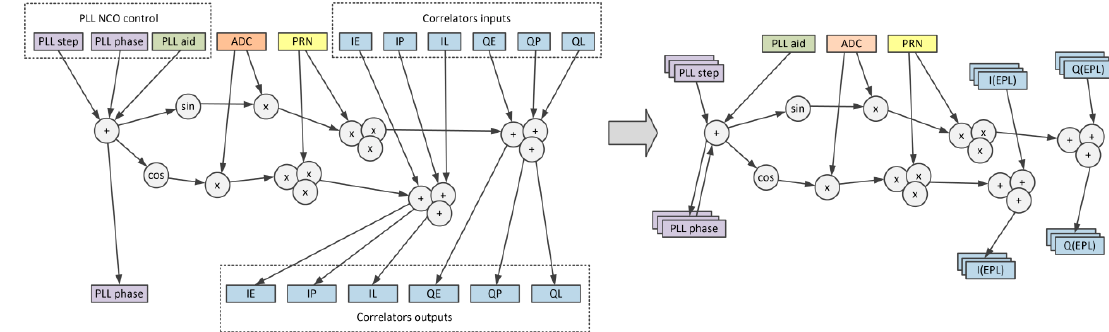
Figure 4. Identification of local variables to form custom register file windows.